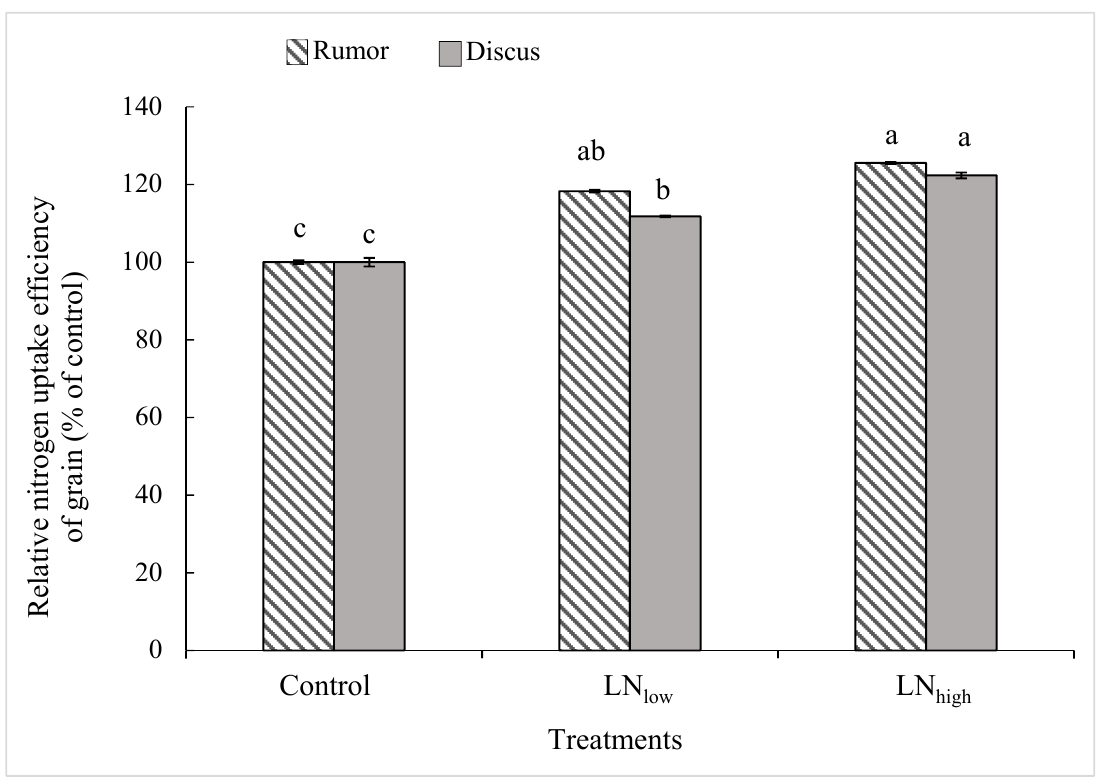
Figure 2. Relative N uptake efficiency of grains (% of control) in response to late application of N fertilizers (Control, LN low , LN high ) for the two cultivars Rumor and Discus. Bars represent mean values ± SE ( n = 3). Different small letters indicate significant differences between all treatment combinations ( p ≤ 0.05).